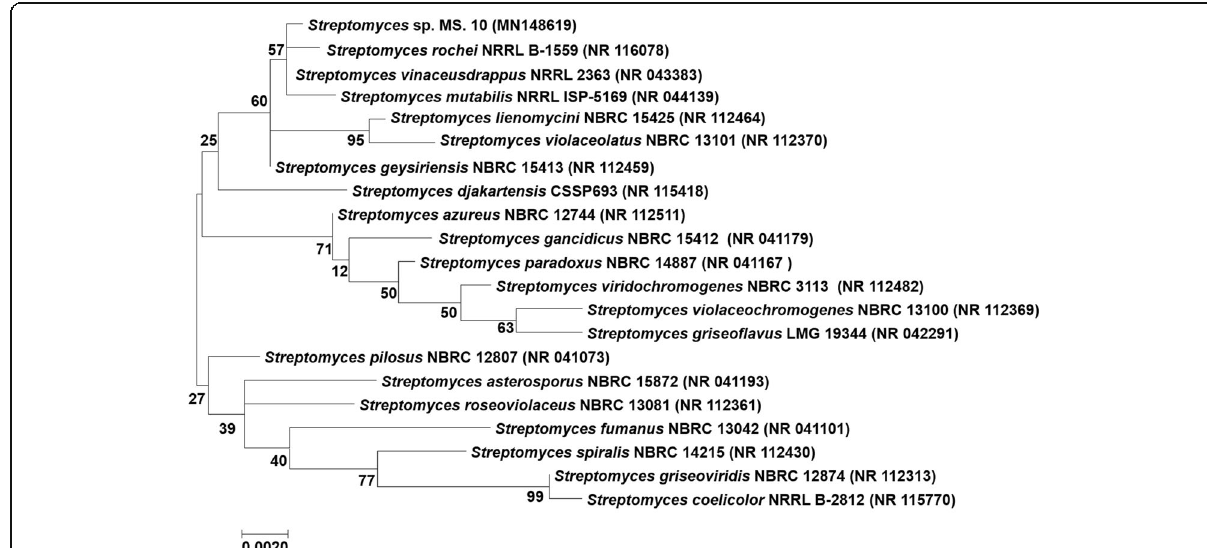
Fig. 1 Phylogenetic tree of Streptomyces sp. MS. 10 based on partial 16S rRNA gene sequences using the maximum likelihood method. The evolutionary history was inferred based on the Kimura 2-parameter model [26]. The tree with the highest log-likelihood ( − 2875.0856) is shown. The percentage of trees in which the associated taxa clustered together is shown next to the branches. The initial tree(s) for the heuristic search were obtained automatically by applying the neighbor-joining and BioNJ algorithms to a matrix of pairwise distances estimated using the maximum composite likelihood approach and then selecting the topology with the most superior log-likelihood value. The tree is drawn to scale, with branch lengths measured in the number of substitutions per site. The analysis involved 21 nucleotide sequences. All positions containing gaps and missing data were eliminated. There were 1400 positions in the final dataset. The evolutionary analyses were conducted using the MEGA7 software